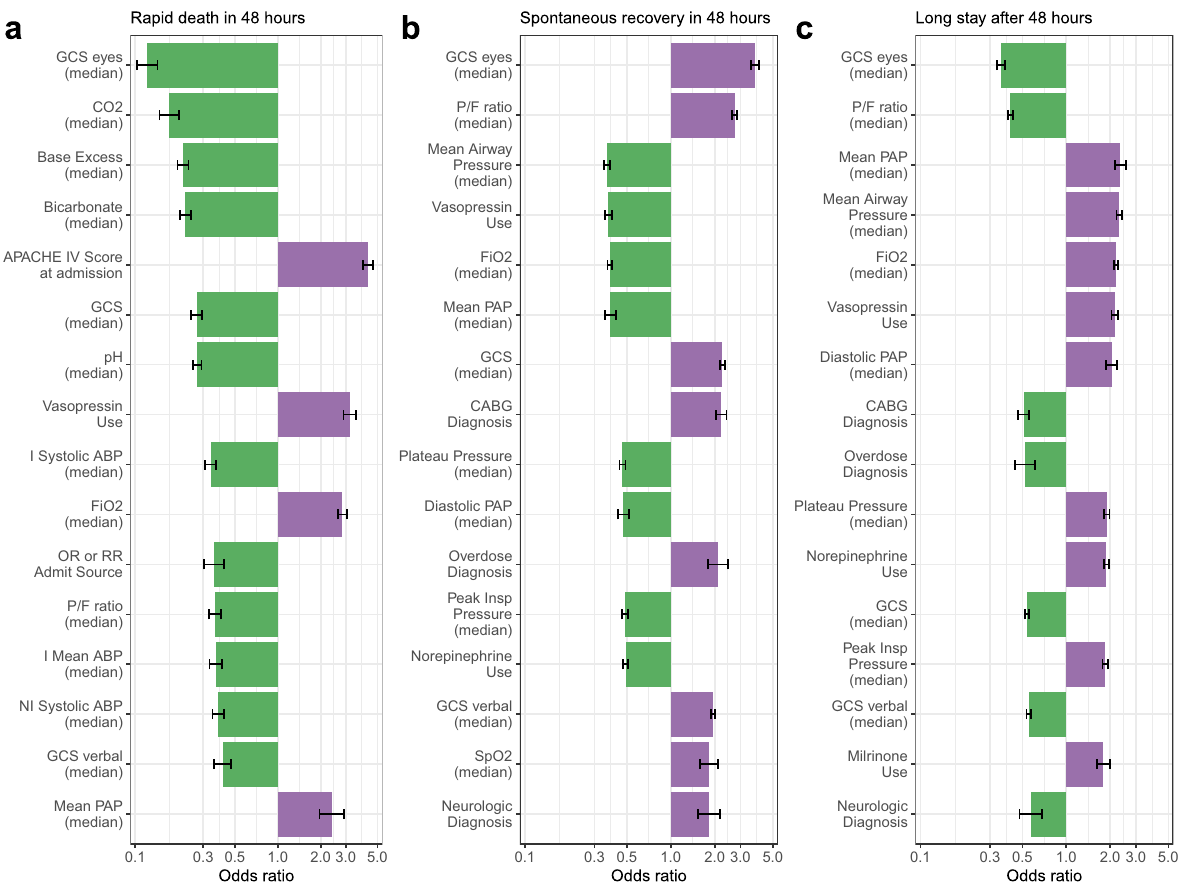
Fig. 4 Top univariate associations with patient status 48 h after identi fi cation. Univariate logistic regressions were run associating each variable with three outcomes: rapid death vs. spontaneous recovery or long stay ( a ), spontaneous recovery vs. rapid death or long stay ( b ) long stay vs. spontaneous recovery or rapid death ( c ). Only the 15 signi fi cant features with the largest effects are plotted. Patients were categorized as rapid death (died within 48 h of identi fi cation), spontaneous recovery (had no ARDS after 48 h post-identi fi cation), or long stay (continued to have ARDS events after 48 h post-identi fi cation). Each time-varying predictor (e.g., PaCO 2 ) was summarized over the fi rst 24 h after identi fi cation using either the median or a missingness indicator (1 if measured, 0 if not). Each continuous predictor (e.g., median PaCO 2 or age) was normalized by the difference in the 20th and 80th percentiles. Green bars indicate that higher variable values are associated with a lower risk of the outcome; purple bars indicate that higher variable values are associated with a higher risk of the outcome. CO2 ’ s negative relationship with rapid death is due to its dependence on bicarbonate. Error bars represent 95% con fi dence